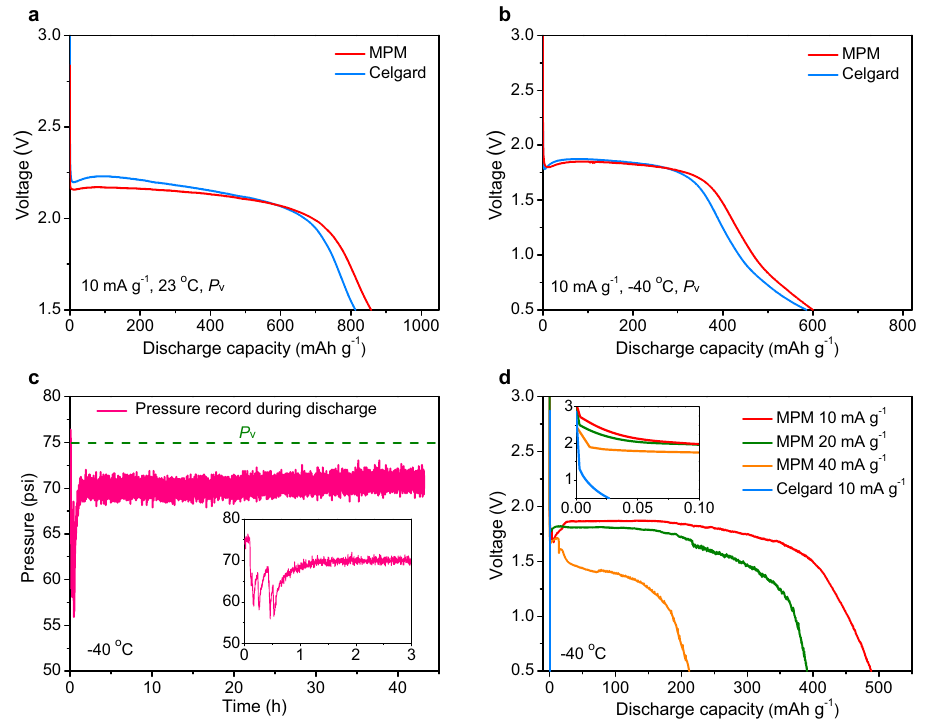
Fig. 5 Cell performance of Li//CF x cells. Discharge characteristics of Li//CF x cells based on Celgard 2400 or MPM at room temperature ( a ) and − 40 °C ( b ) under vapor pressure. c In situ monitoring the interior pressure of Li//CF x cell at − 40 °C during the process of discharge. d Discharge characteristics of Li//CF x cells based on Celgard 2400 or MPM at − 40 °C, 70 psi and different discharge current density beneath vapor